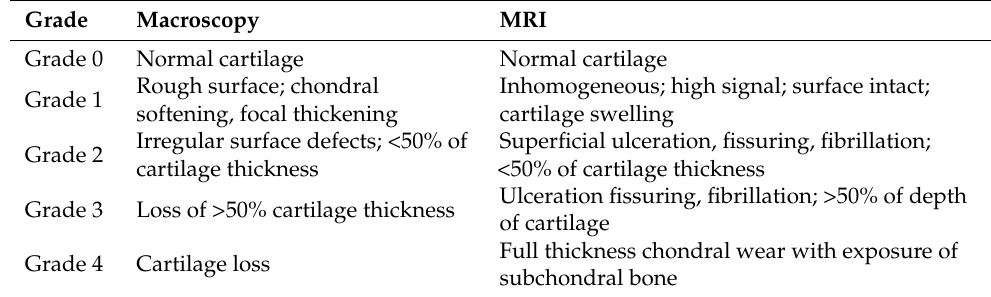
Table 1. Modified Outerbridge